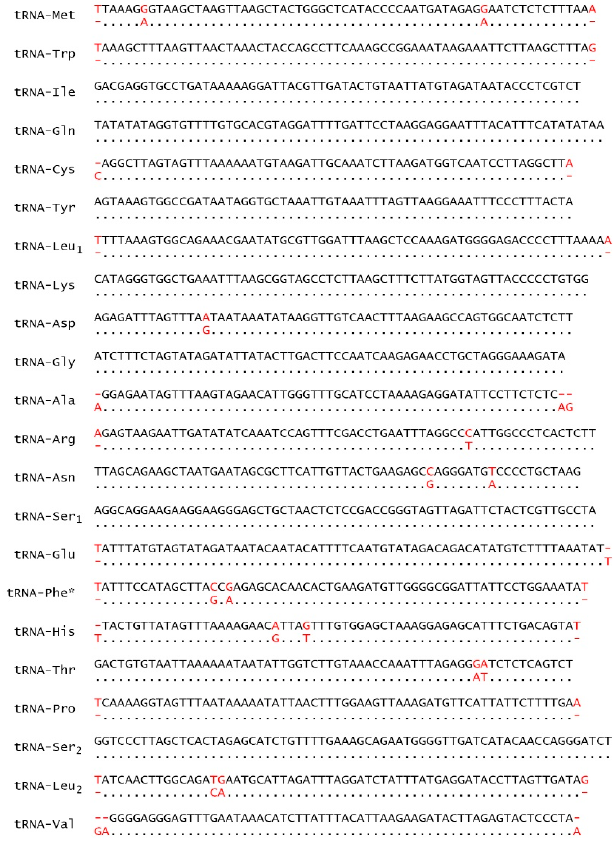
Figure 6. The partial map ( a ) and sequence alignment ( b ) of NC_021382 by Zhang et al. [26] showing duplicated part in control region. (NC_021382 has been corrected by NCBI staff. The reference sequence is identical to JQ975176).